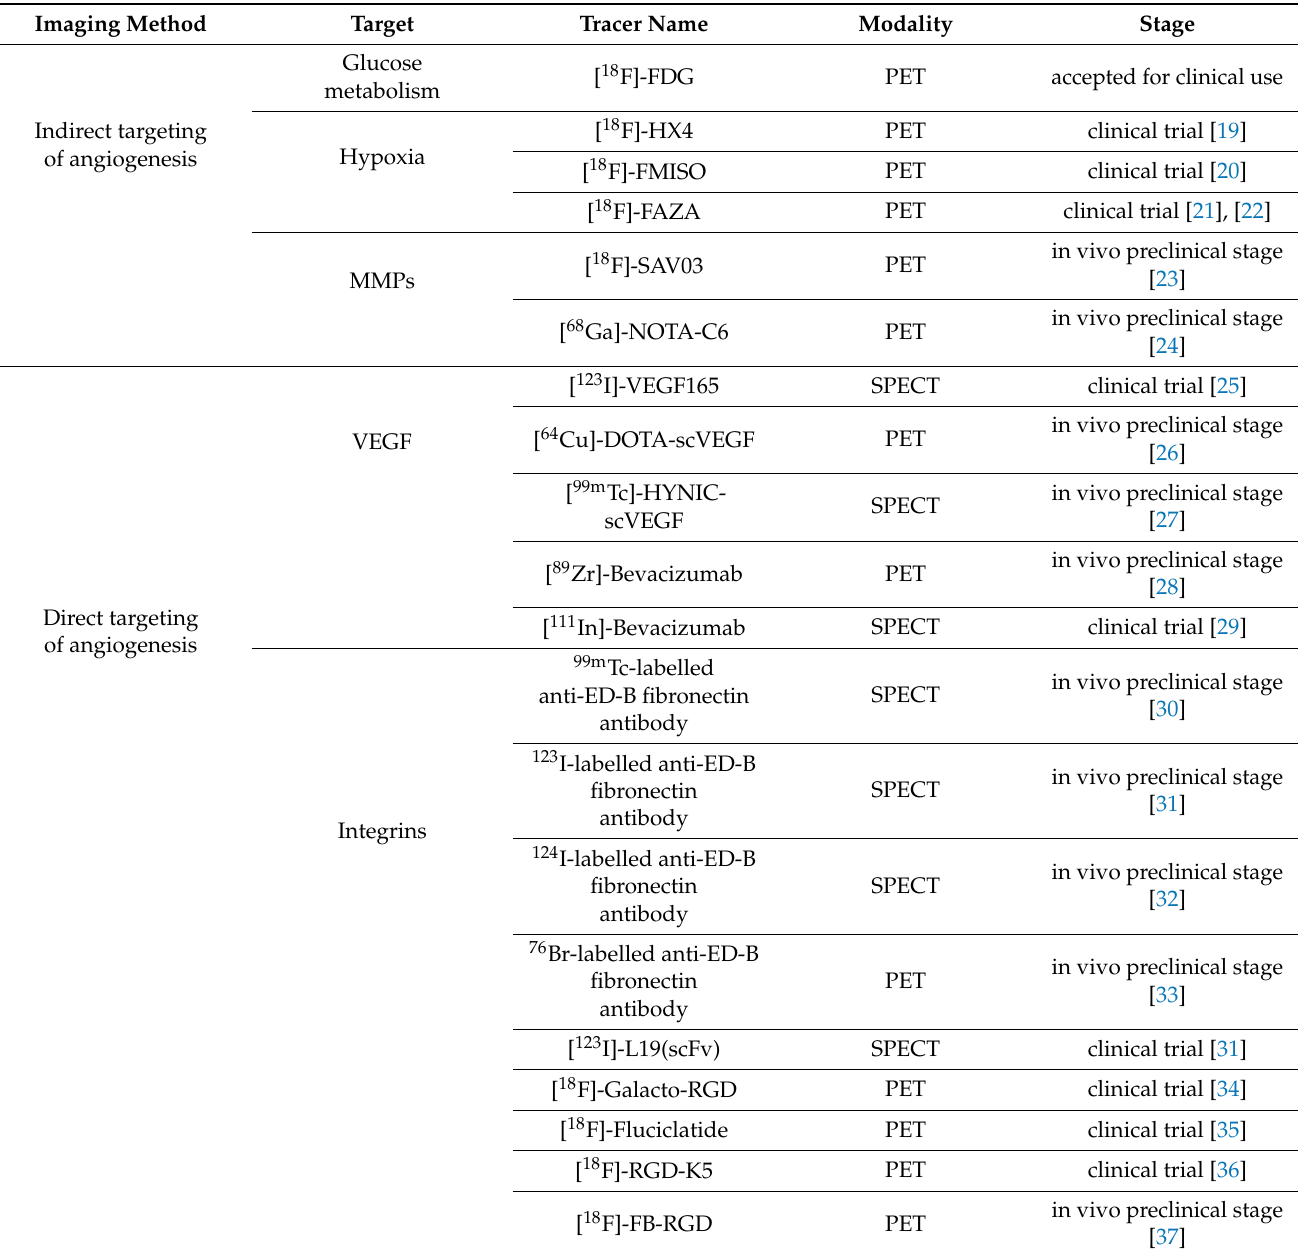
Table 1. Classification of the most promising tracers for angiogenesis